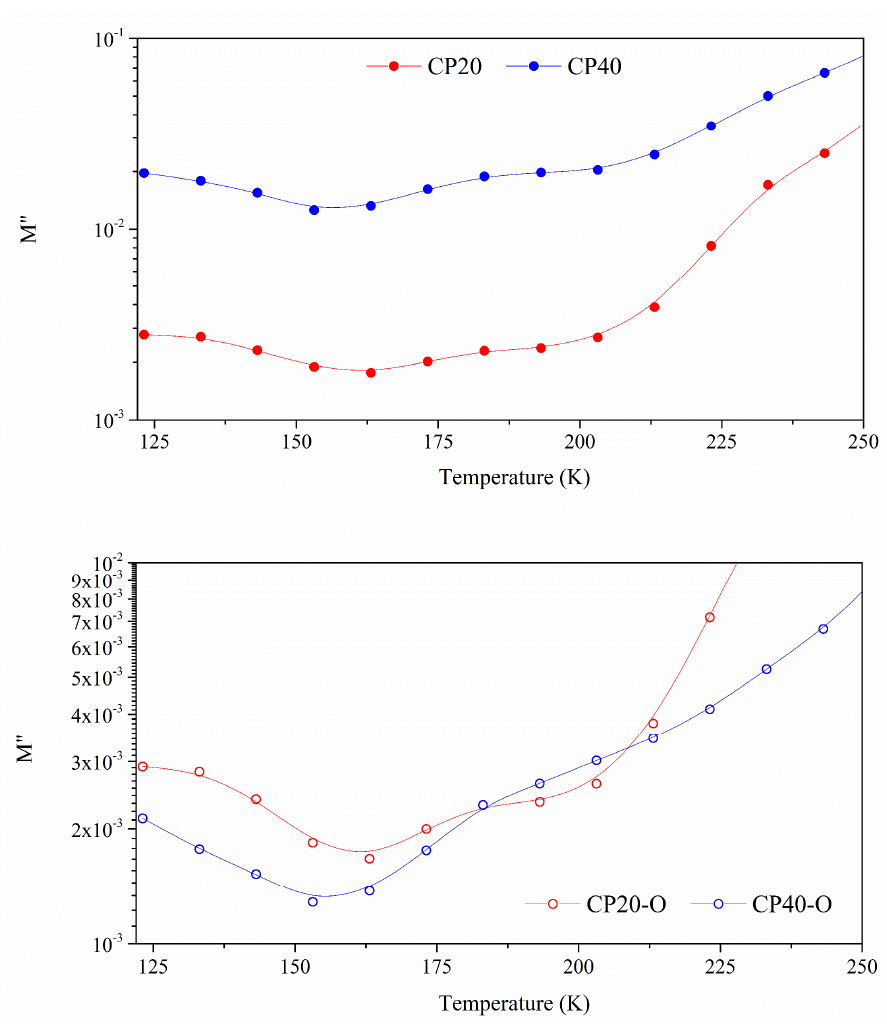
Figure 9. Loss modulus for the unoriented ( top ) and oriented ( bottom ) modified copolymers at 10 − 1 Hz frequency.